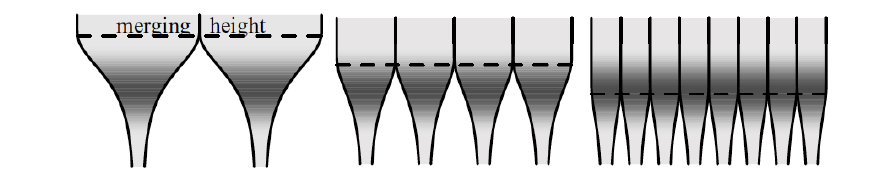
Figure 32: Schematic representation of models of the emission of chromospheric lines outlining the main effects of a changing magnetic filling factor (longterm evolution from right to left). The emitting layer is represented by the darker gray bands. Observations are not able to resolve the flux tubes, but measure the mean excess flux, Δ ¯ 𝐹 , and the mean magnetic flux, ¯ 𝐵 . The same atmosphere is present as ¯ 𝐵 decreases from right to left, while the merging height increases. This leads to a natural decrease of Δ ¯ 𝐹 with decreasing ¯ 𝐵 . Owing to the changing merging height with ¯ 𝐵 , Δ ¯ 𝐹 saturates for increasing ¯ 𝐵 as the magnetic flux tubes get into contact in the emission region (on the right). This is a representation of the hydromagnetic model by Solanki et al. (1991) of an expanding flux tube for the interpretation of Ca ii K line flux, and explains well the results for the evolution of chromospheric emission during the evolution of AR 7978 by D´emoulin (2004), from where the image is reproduced with permission, copyright by